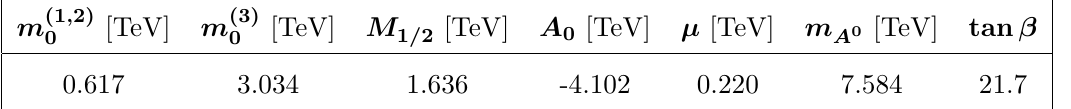
Table 4 . Input parameters for the benchmark